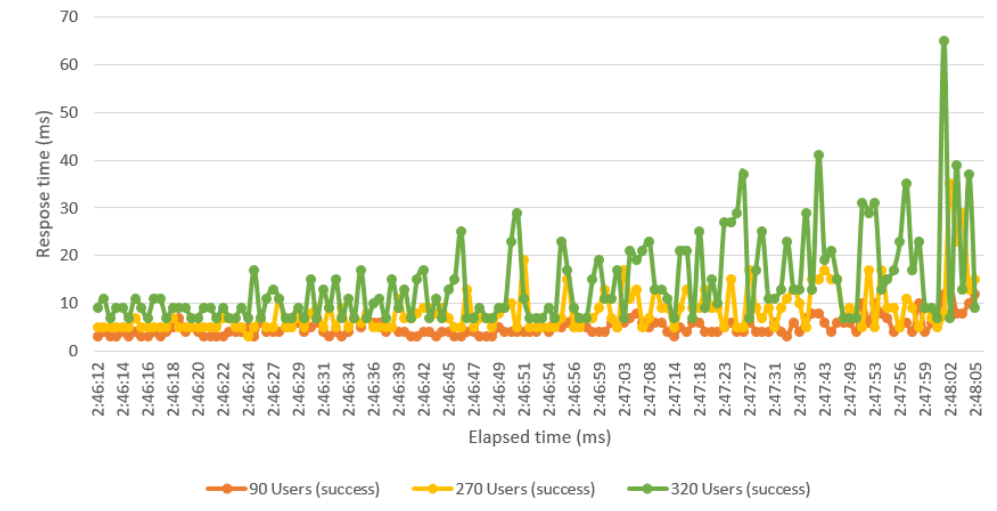
Figure 22. Response time for different query requests.